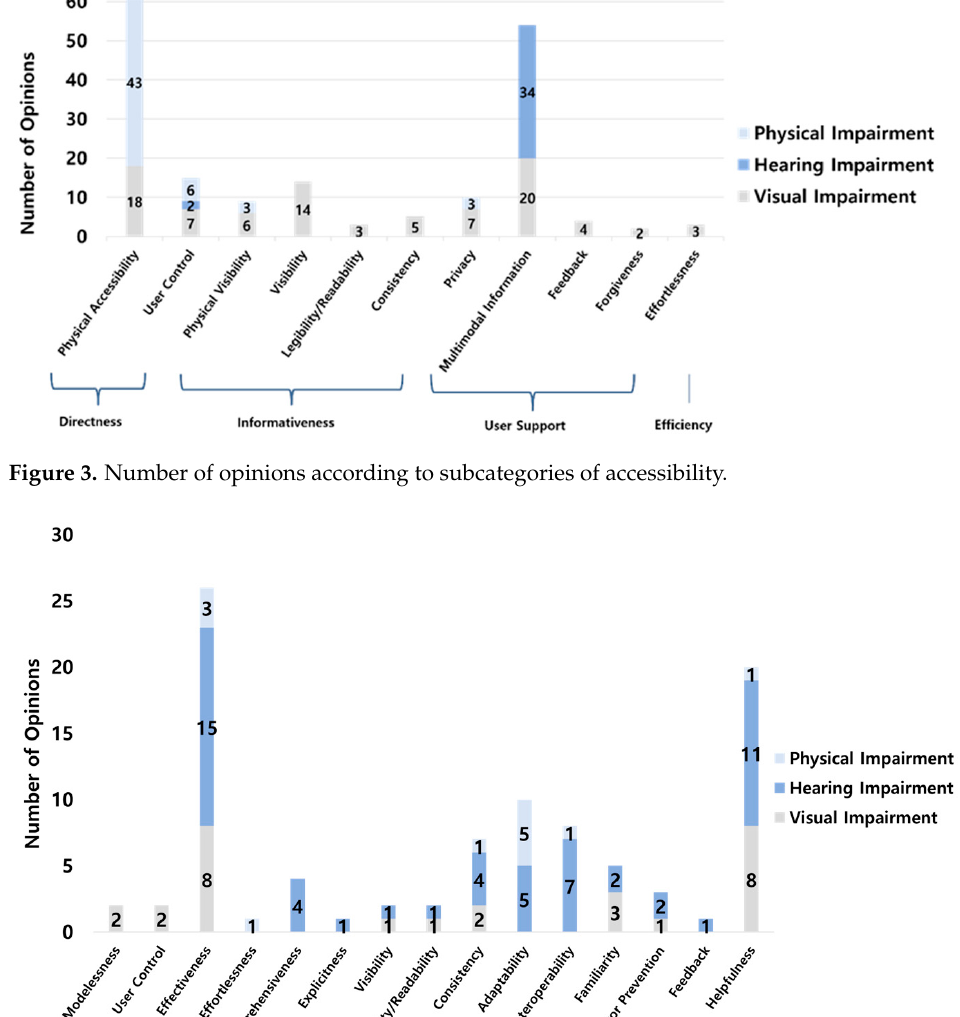
Figure 2. Number of accessibility and usability items by type of impairment.